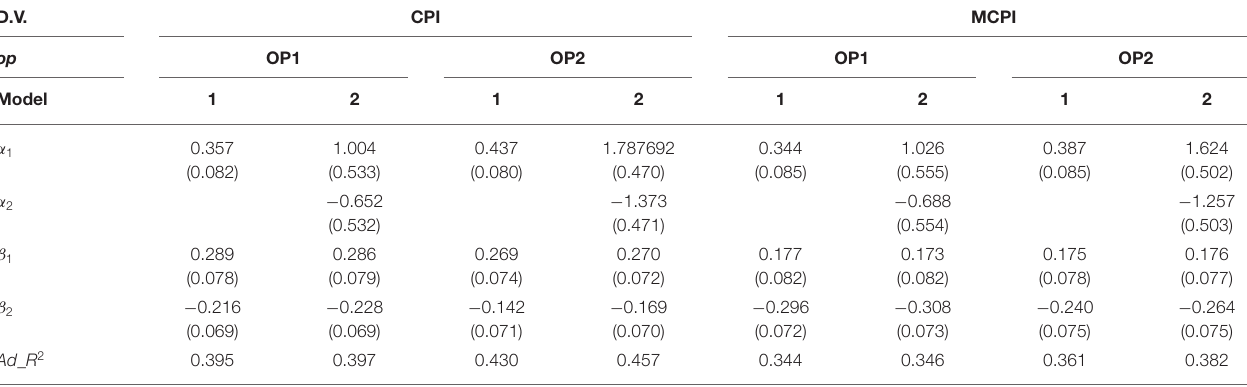
TABLE 4 | The relationships between oil prices and consumer